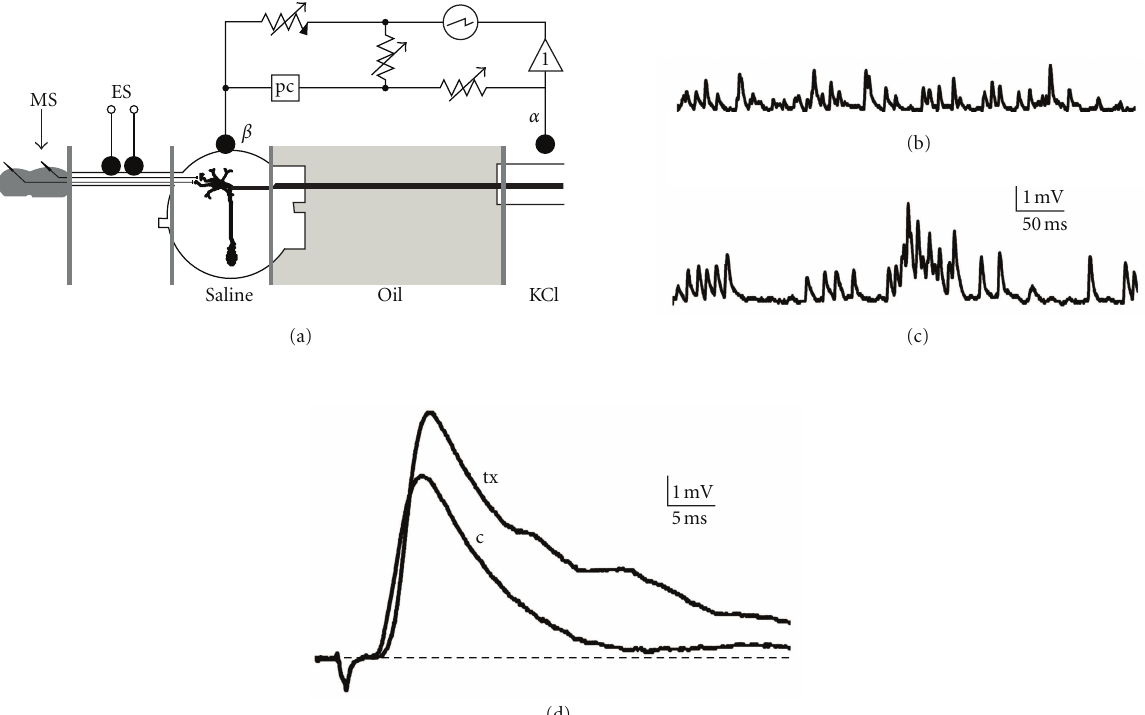
Figure 6: Single-fiber oil-gap method applied for studying synaptic transmission between cercal nerve and giant interneurone. (a) The scheme of electronic circuit used to record postsynaptic events. Recording electrode ( α ) bathed in isotonic KCl solution is connected with high-input impedance, negative capacitance amplifier (1); extracellular electrode β is in contact with last abdominal ganglion. Wheatstone bridge is connected to recording circuit and it is used to apply polarizing current (pc) through postsynaptic membrane. The desheated ganglion is superfused with saline or test solution. The dissected axon is bathed in para ffi n-oil. MS—mechanical stimulation, ES—electrical stimulation applied to cercal nerve (according to [59, 60]). (b) Control conditions—unitary excitatory postsynaptic potentials (uEPSP) recorded as spontaneous activity of preparation and (d) c—control excitatory compound postsynaptic potential (cEPSP) observed as the e ff ect of cercal nerve electrical stimulation. (c) The increased spontaneous activity (uEPSPs) and (d) tx—cEPSPs observed 10 min